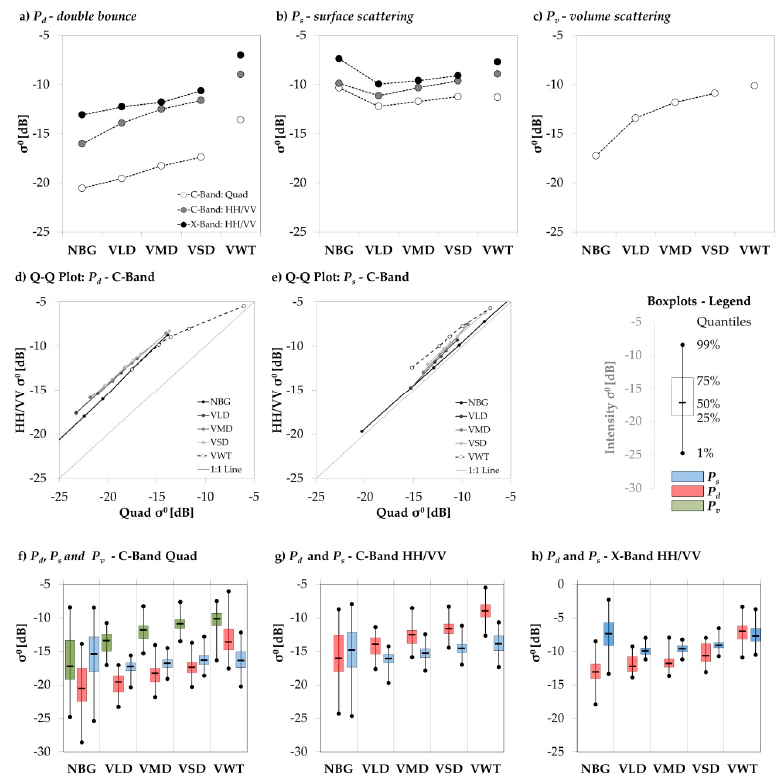
Figure 2. Median sigma nought ( σ ◦ ) backscatter intensities in decibel (dB) of: ( a ) double bounce (P d ), ( b ) surface scattering (P s ) and ( c ) volume scattering (P v ) for none-water land cover classes (NBG, VLD, VMD, VSD, VWT) and for C-Band Radarsat-2 and X-Band TerraSAR-X data. The power decomposition features of “C-Band: HH/VV” and “X-Band: HH/VV” were derived via the purposed two component decomposition. Features of “C-Band: Quad” were calculated using the three component Yamaguchi Decomposition. Schemes ( d ) and ( e ) show the quantile-quantile plots of the two and three component decomposition features double bounce (P d ) and surface scattering (P s ) for the quantiles 1%, 25%, 50%, 75%, and 99%. The boxplots show the decomposition features of: ( f ) C-Band: Quad; ( g ) C-Band: HH/VV and ( h ) X-Band: HH/VV. Note that NBG, VLD, VMD, and VSD are in an ordinal scale and vegetation height and density is increasing from NBG to VSD .